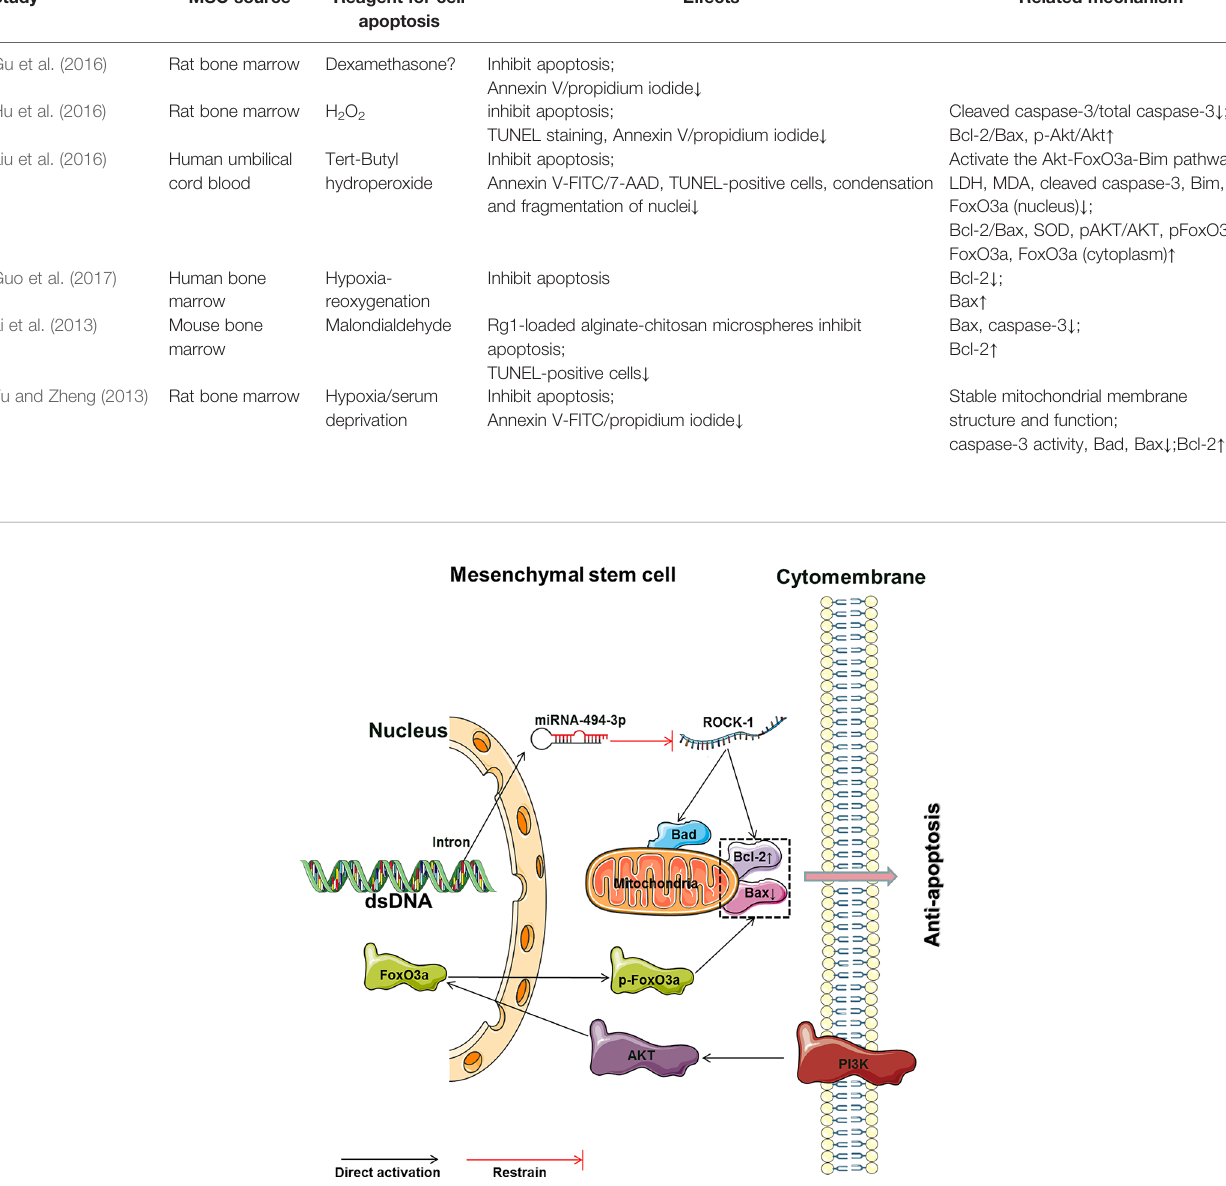
FIGURE 3 | The main molecular mechanism by which Rg1 affects the apoptosis of MSCs (Bad, Bcl2-associated agonist of cell death; Bcl-2, B cell lymphoma 2; Bax, B cell lymphoma/leukemia-2-associated X protein; ROCK-1, Rho-associated coiled-coil containing protein kinase 1; PI3K, phosphoinositide 3-kinases; AKT, protein kinase B; FoxO3, forkhead box O3; p-FoxO3, phosphorylated forkhead box